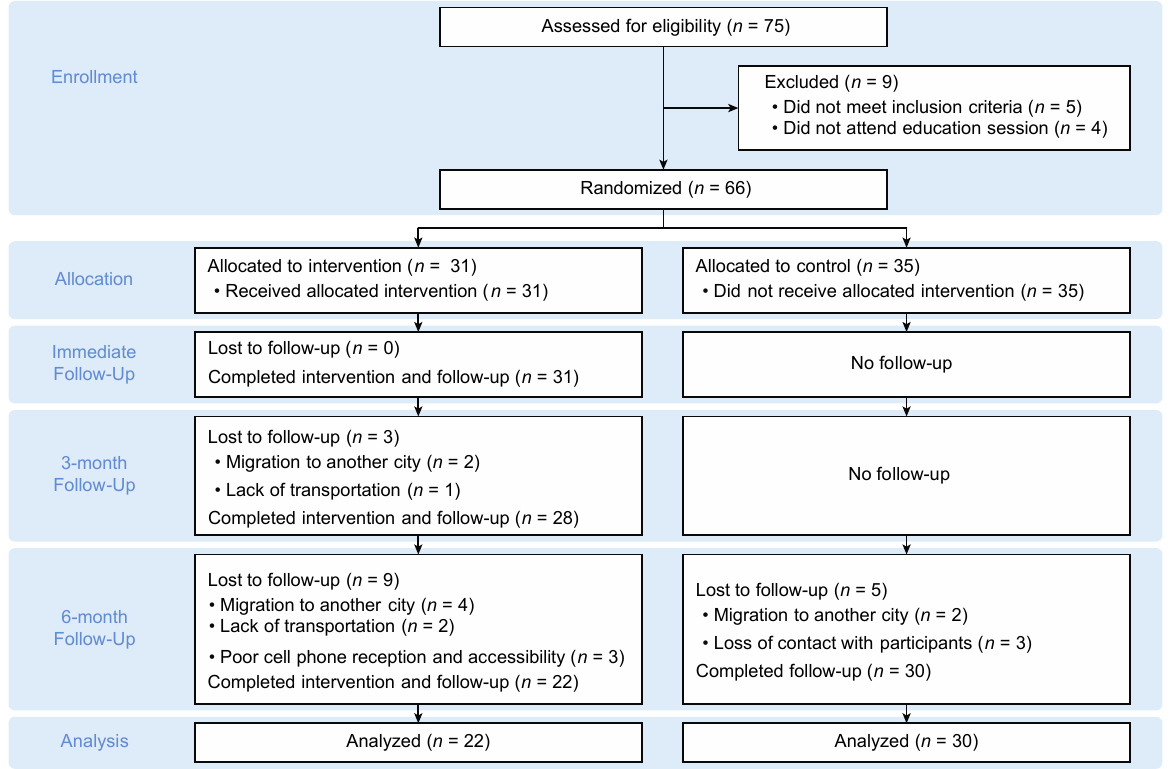
Figure 1. Flow diagram of the recruitment of the participants in the intervention group and the control group.